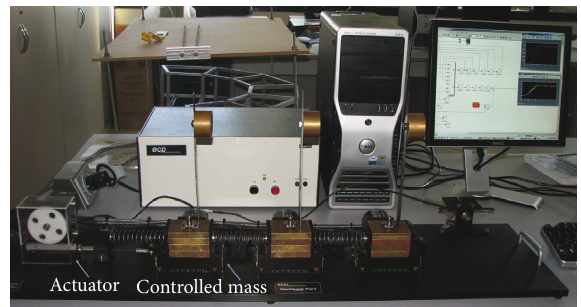
Figure 3: Configuration of the experimental setup used to test the performance of the proposed control